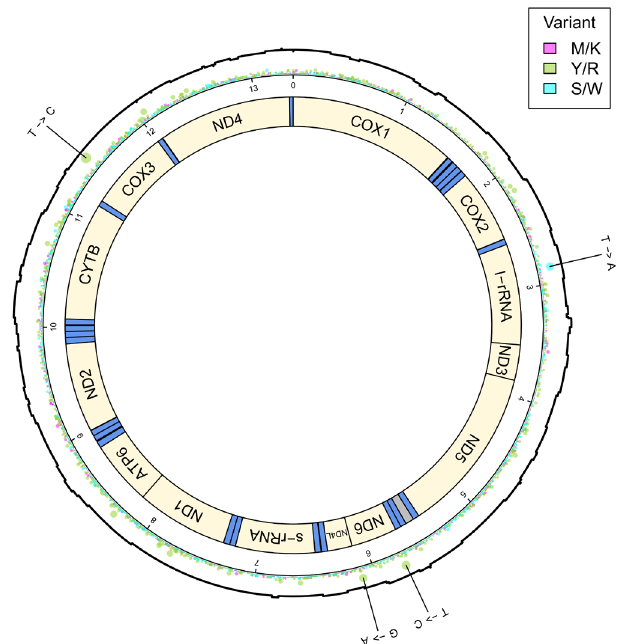
Figure 1. Diagram of mtDNA with mapped MinION read coverage. Gene regions are displayed in this circular mitochondrial DNA diagram in yellow, with tRNA regions in blue. The AT-rich region between the ND5 and ND6 genes is shaded grey. A combined coverage/variant plot is also displayed, showing MinION read coverage (in black), and base-called transition, transversion, and complementary variants (in chartreuse, magenta and cyan, respectively). Variant differences between Wellcome Trust Sanger Institute and Malaghan Institute of Medical Research strains of Nippostrongylus brasiliensis are indicated on the perimeter of the